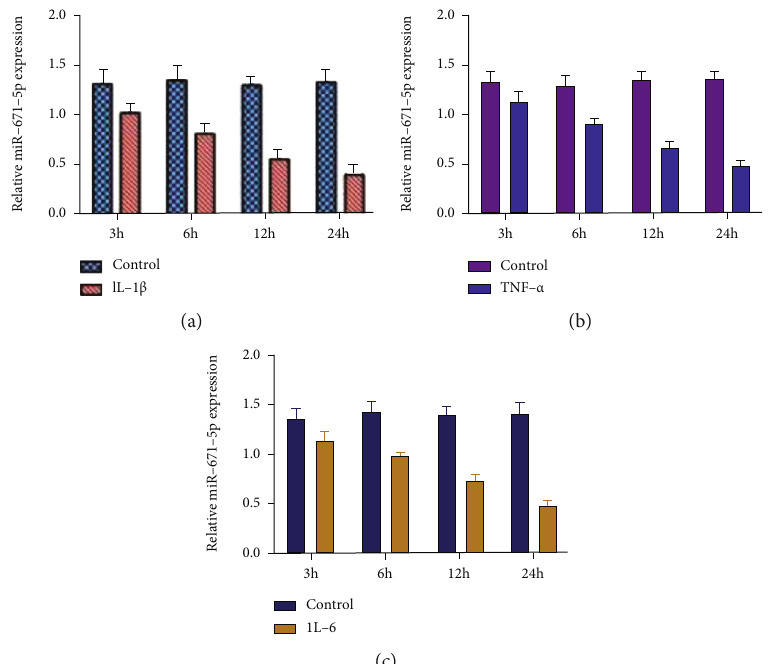
Figure 5: In fl ammatory mediators IL-1 β , TNF- α , and IL-6 suppressed miR-671-5p expression. (a) The expression of miR-671-5p was detected by qRT-PCR assay. (b) TNF- α suppressed miR-671-5p expression in chondrocytes. (c) IL-6 inhibited miR-671-5p expression in chondrocytes.